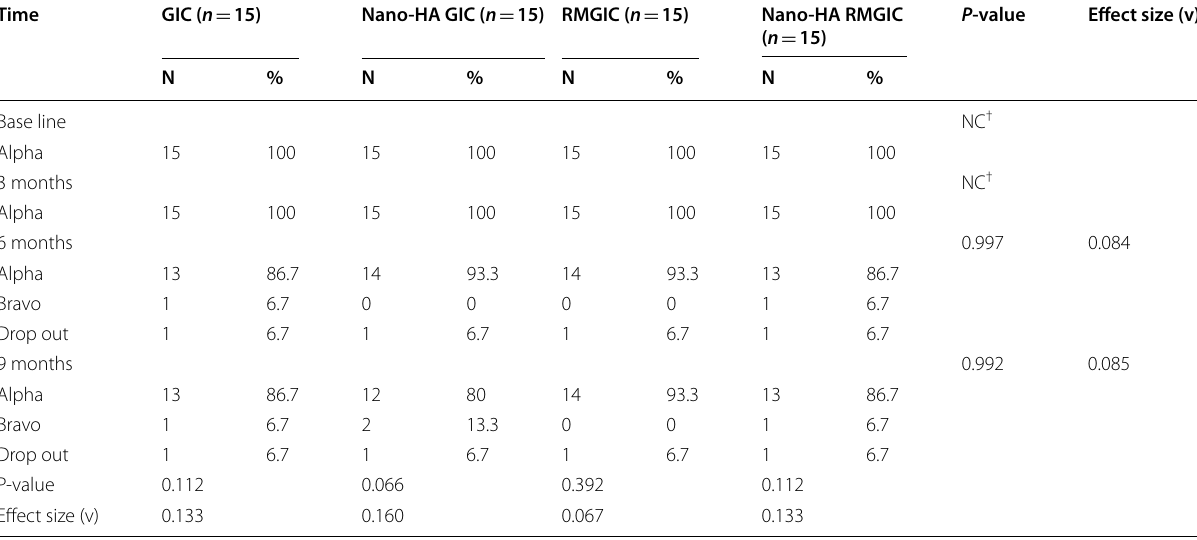
*Significant at P